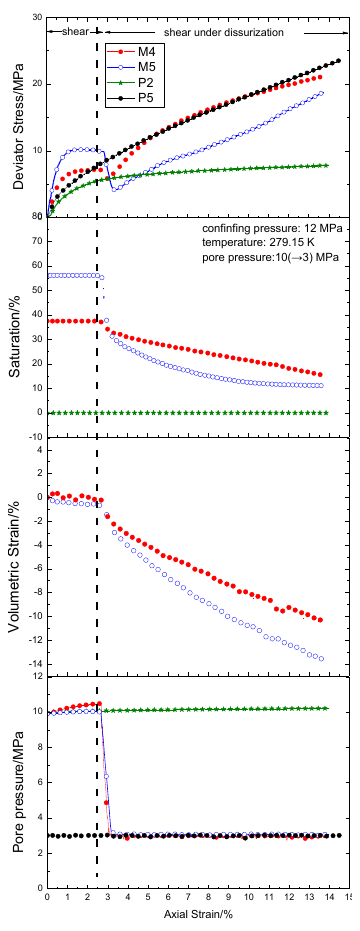
Figure 5. Deviator stress, volumetric strain, pore pressure, and axial strain relationships of specimens with various saturation levels.